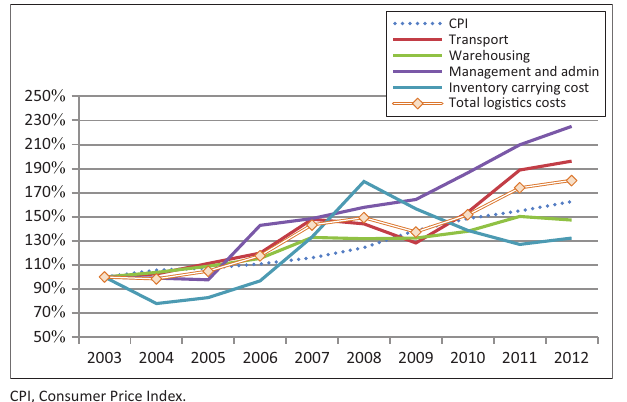
FIGURE 5: Growth of South African logistics cost components compared to the Consumer Price Index, 2003–2012.